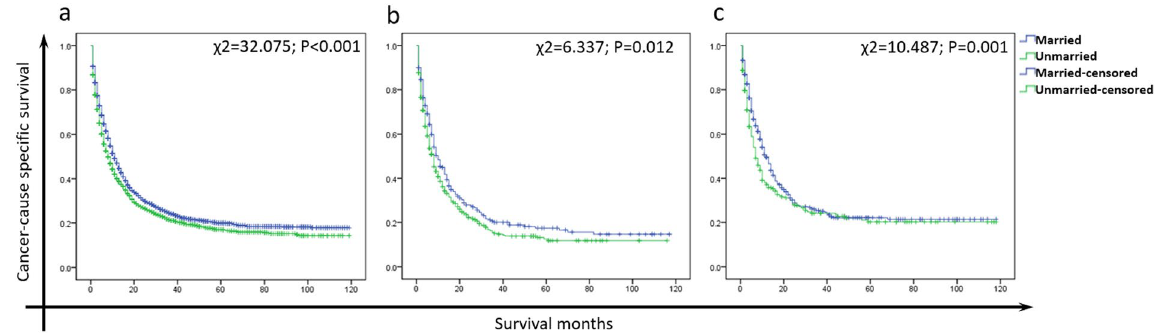
Figure 4. The survival curves of white ( a ), black ( b ) and other ( c ) GBC patients with different marital status. ( c ) American Indian/AK Native, Asian/Pacific